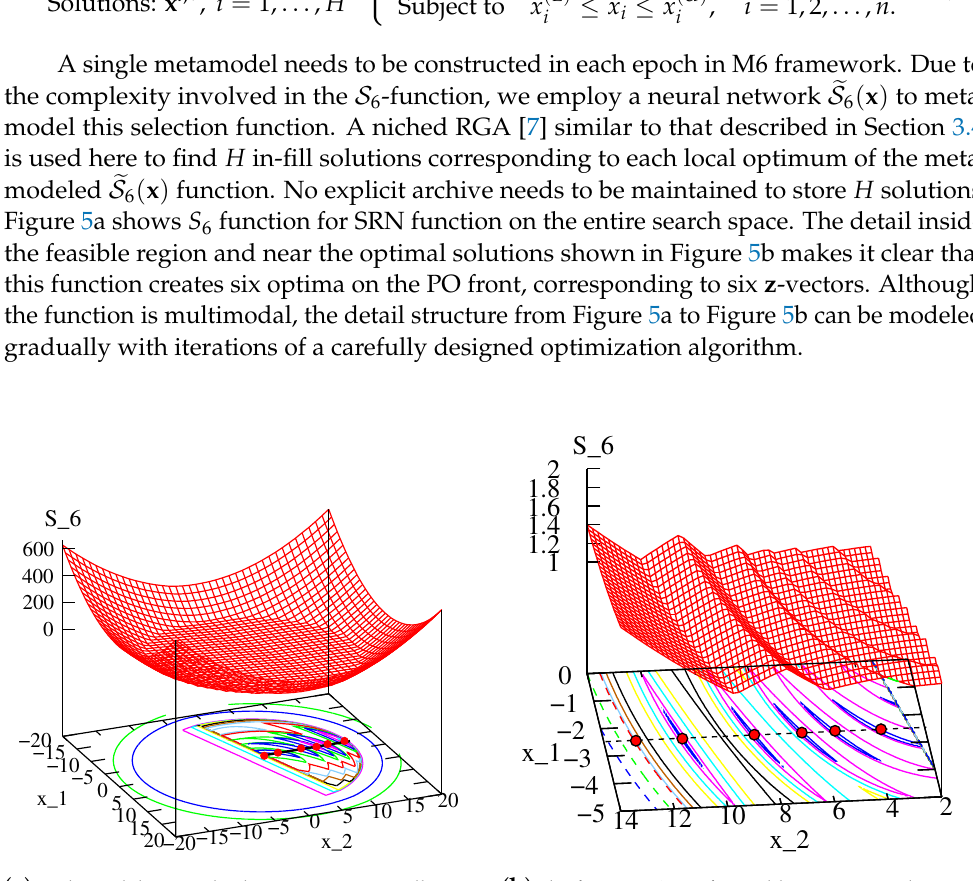
Figure 5. The function S 6 surface is blown up near the optimal region showing six